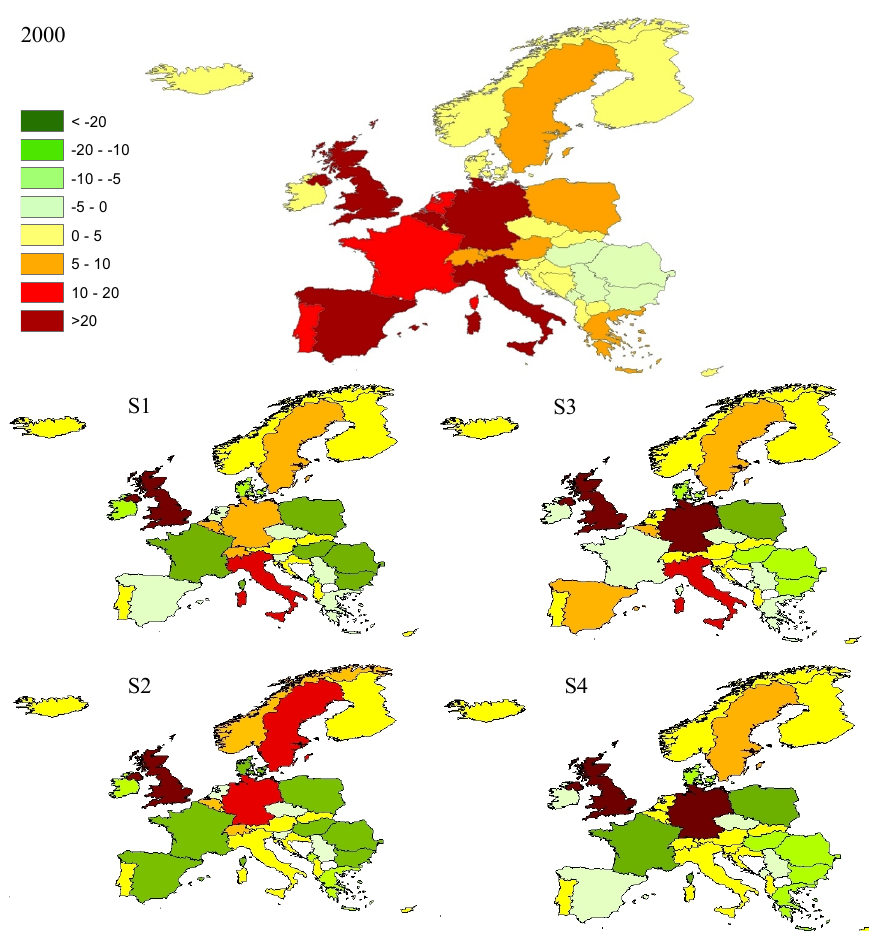
Figure 8. Net virtual water import per European country (billion m 3 year). Positive values represent net virtual water import; negative values represent net virtual water export.